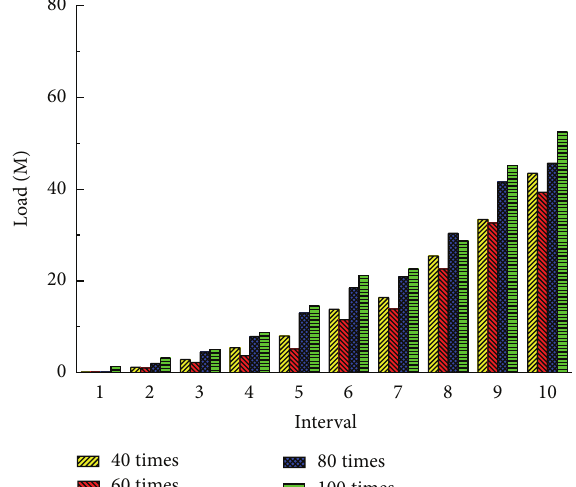
Figure 5: Total load of communication (20 nodes).